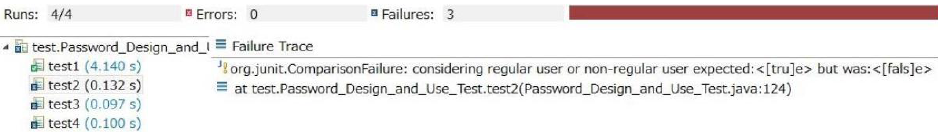
Figure 14. Test results (Password Design and Use pattern).